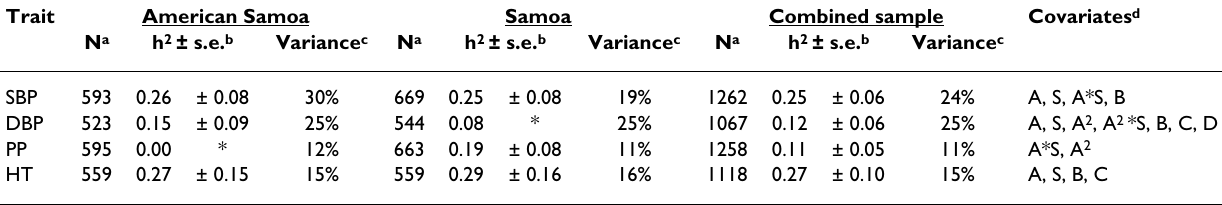
Table 2: Heritability estimates, variance and summary of significant covariates for each trait.